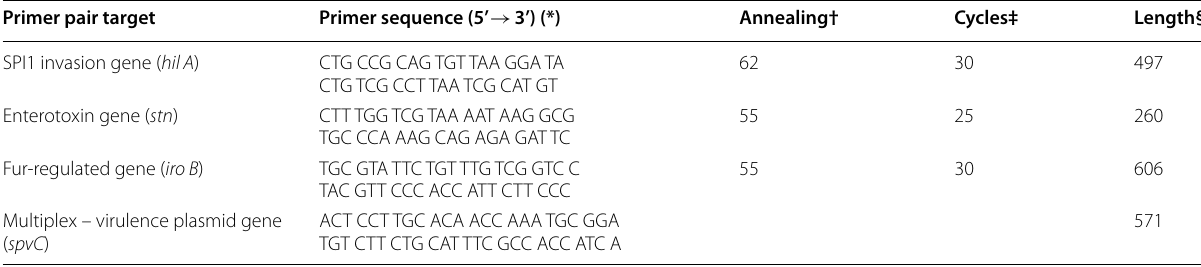
* The Primer sequence shows forward primer listed first followed by the reverse primer † Annealing temperature in ̊ C ‡ Cycles the number of times the dissociation, annealing and elongation steps were repeated for amplification = § Length of amplification product in base pairs